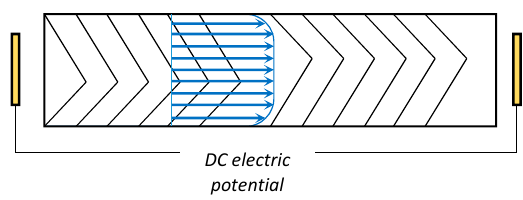
Figure 1. Schematic of two driven modes in this work, hydrodynamic flow and electro-osmotic flow.